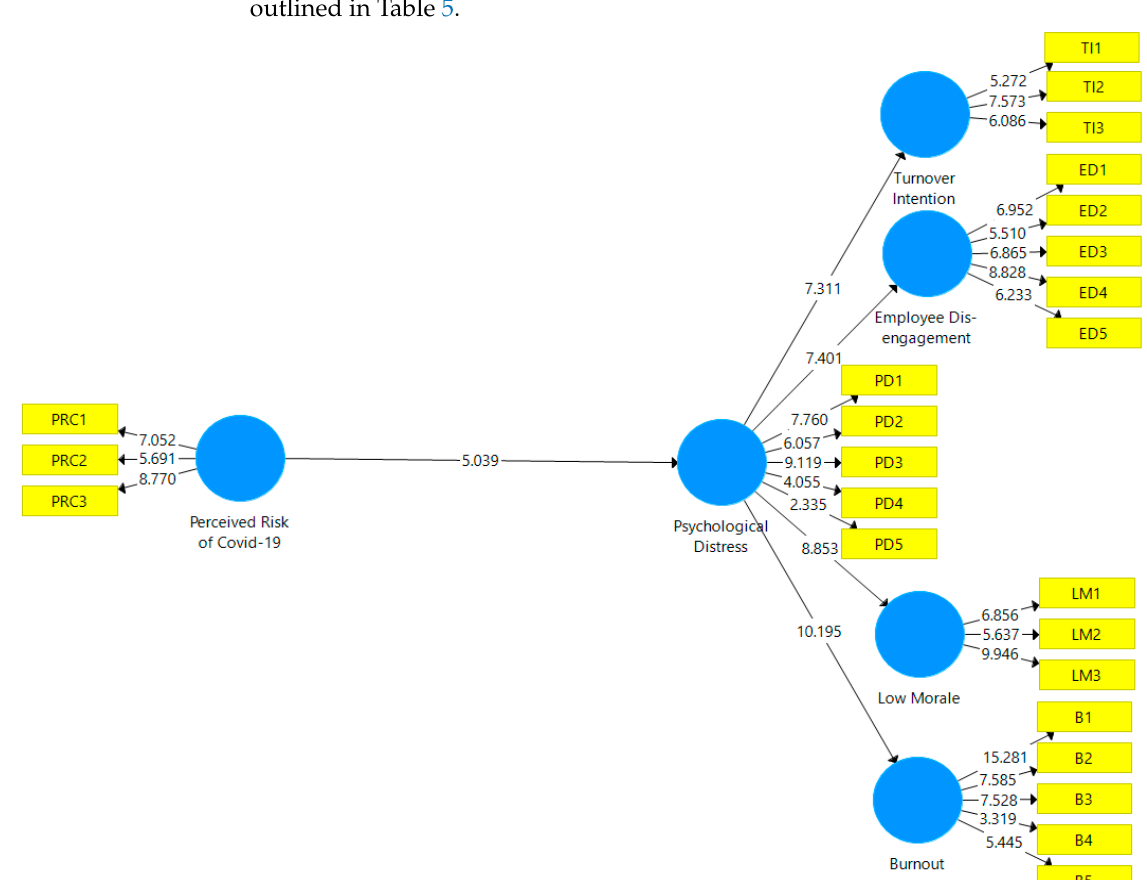
Figure 3. Hypotheses testing.